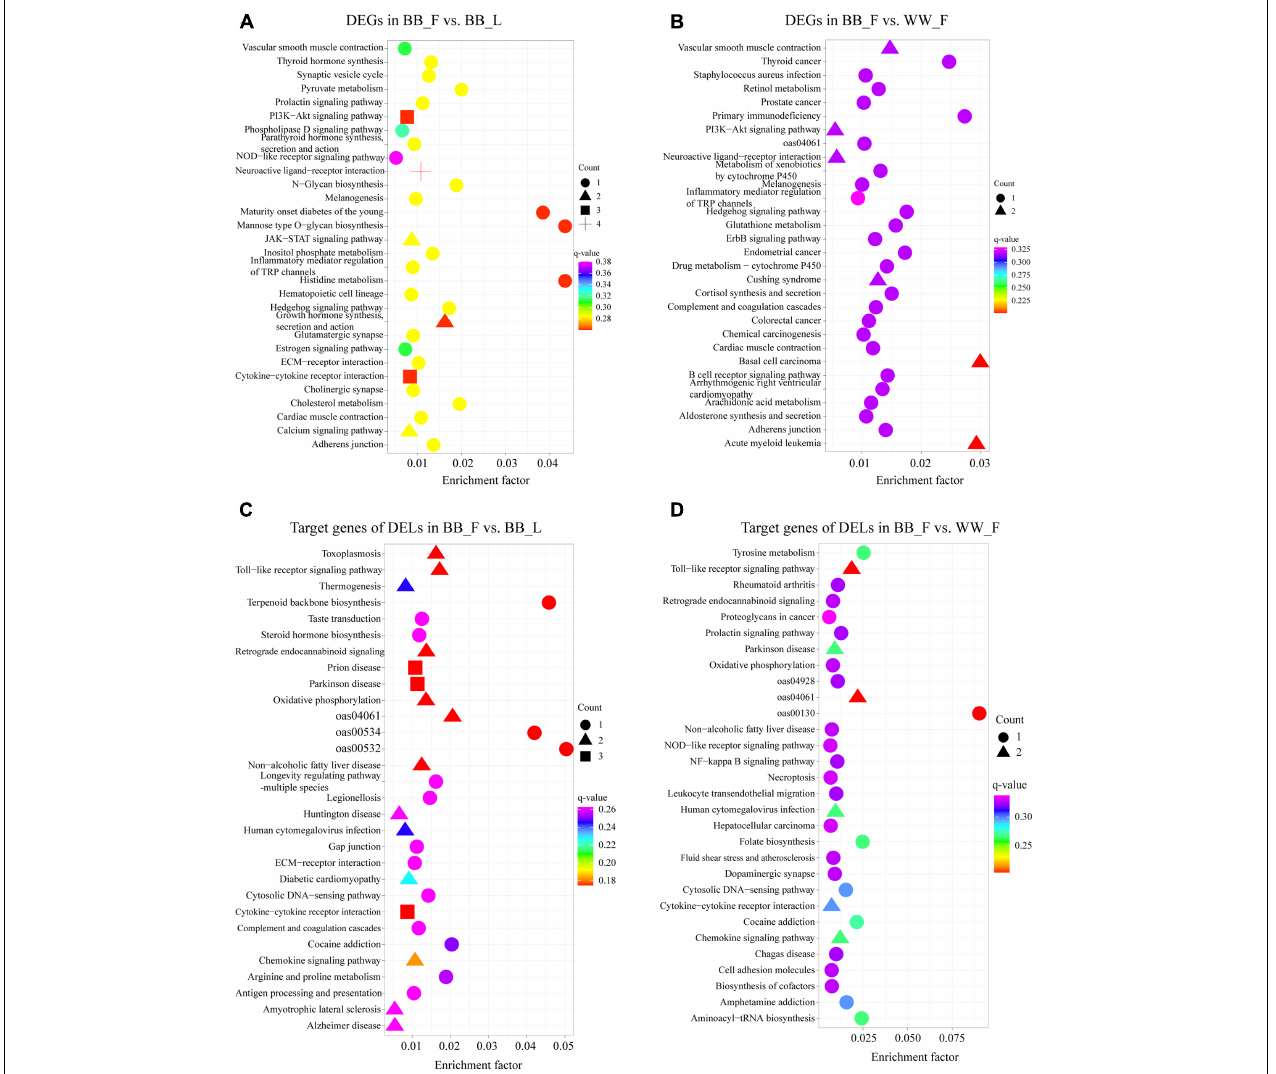
FIGURE 3 | Top 30 enriched KEGG pathways related to hypothalamic function and reproductive process of DEGs and target genes of DELs. Enrichment factor is the ratio of differentially expressed gene numbers annotated in this pathway terms to all gene numbers annotated in this pathway term. (A) KEGG enrichment pathways for DEGs in BB_F vs. BB_L. (B) KEGG enrichment pathways for DEGs in BB_F vs. WW_F. (C) KEGG enrichment pathways for potential target genes in BB_F vs. BB_L. (D) KEGG enrichment pathways for potential target genes in BB_F vs.